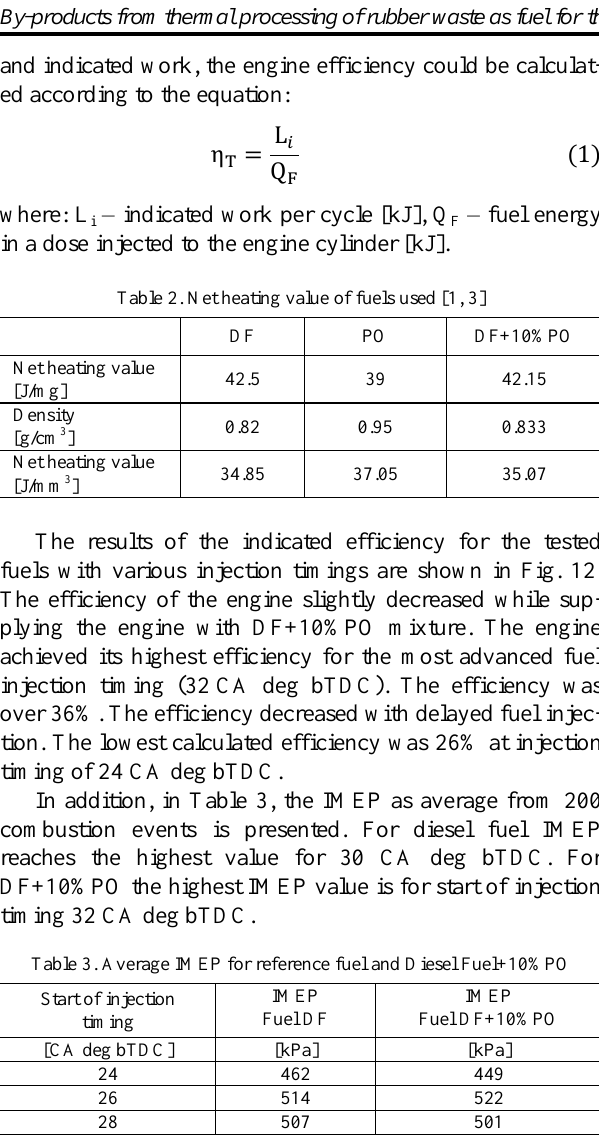
Fig. 12. Indicated thermal efficiency curves